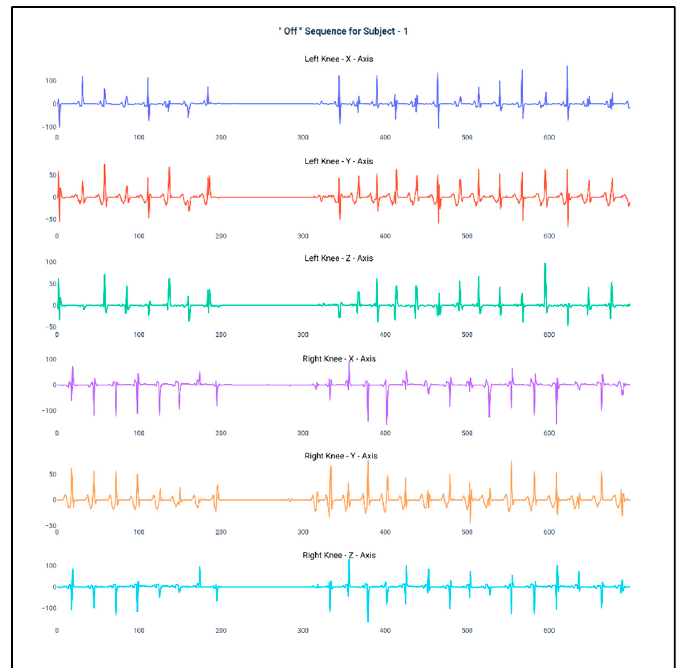
Figure 1. Accelerometer signals of subject 1 for 750 samples during “Off” state.